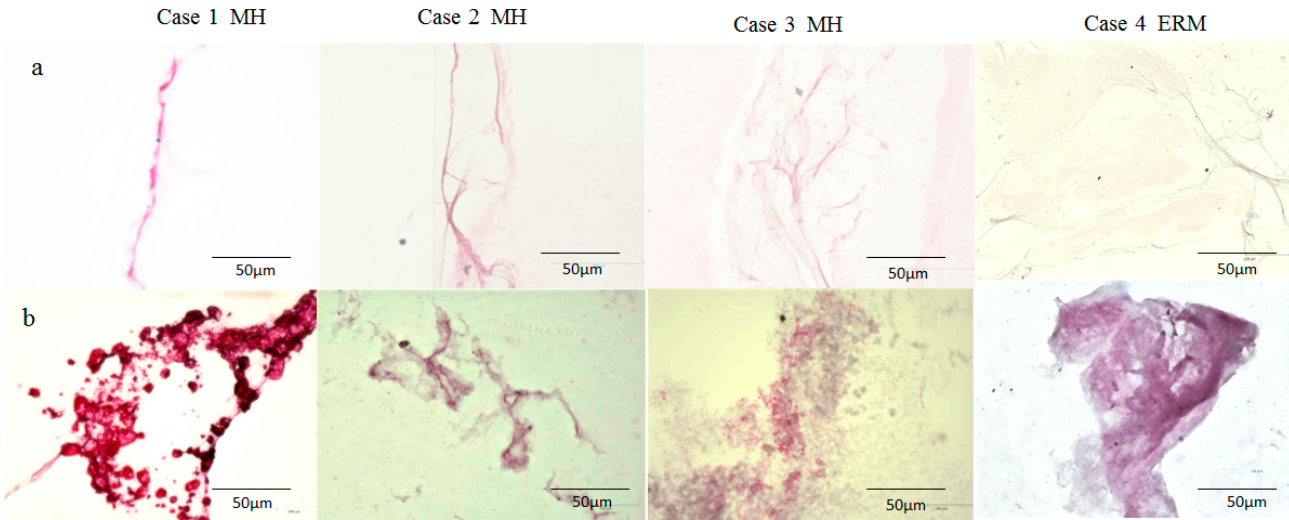
Figure 4. Immunostaining of the BPM with antibodies for fibrillin-2. Similar to fibrillin-1, the VC of patients with MH and ERM was faintly stained with antibodies for fibrillin-2 ( a ) whereas the BPM was intensely stained ( b ).